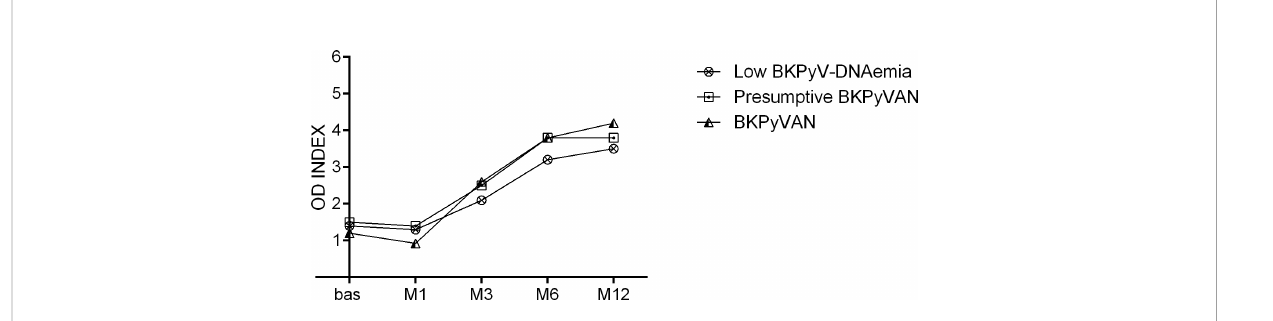
FIGURE 6 Seroreactivity during the follow-up in recipients with BKPyVAN, presumptive BKPyVAN, and low BKPyV-DNAemia. Legend: